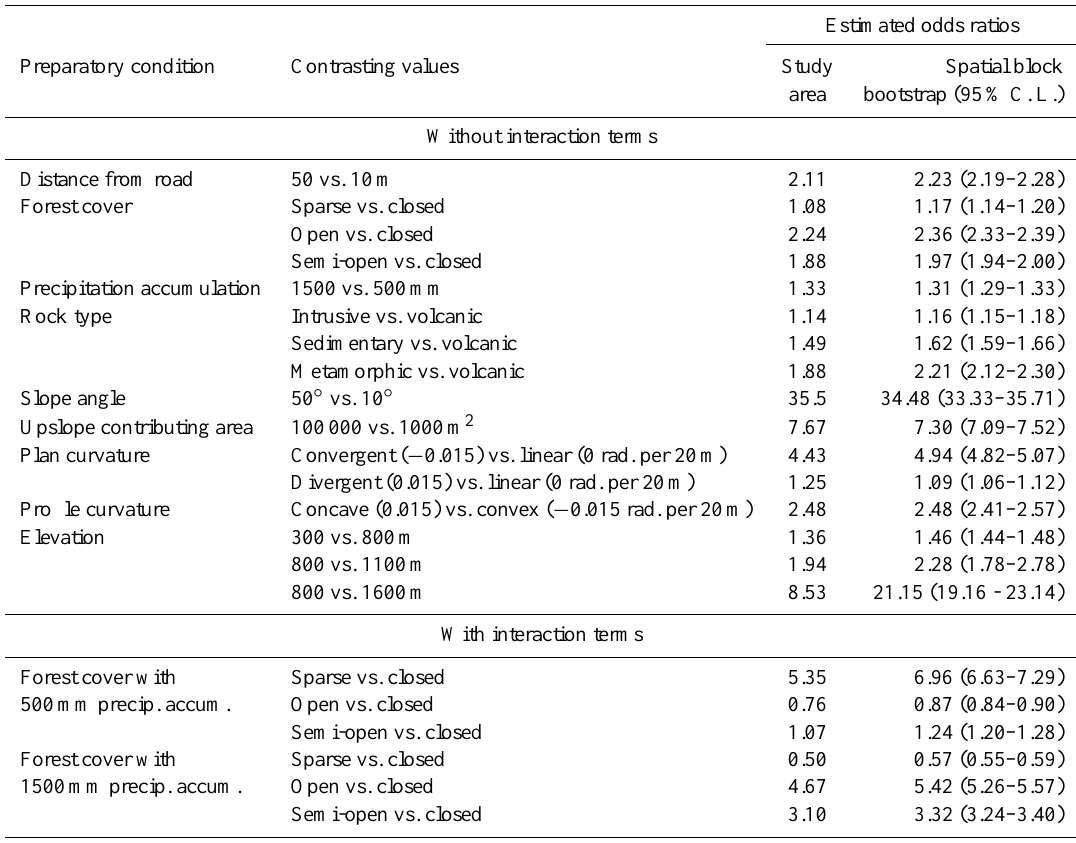
Table 6. The effect size of various contrasting values estimated from the two GAM models (with and without an interaction term) for each preparatory condition associated with landslide initiation. The odds ratios were estimated for the complete observations in the study area and using a spatial block bootstrap technique. The mean and percentile-based 95% confidence limits (C. L.) of the estimated bootstrap odds ratios are presented.